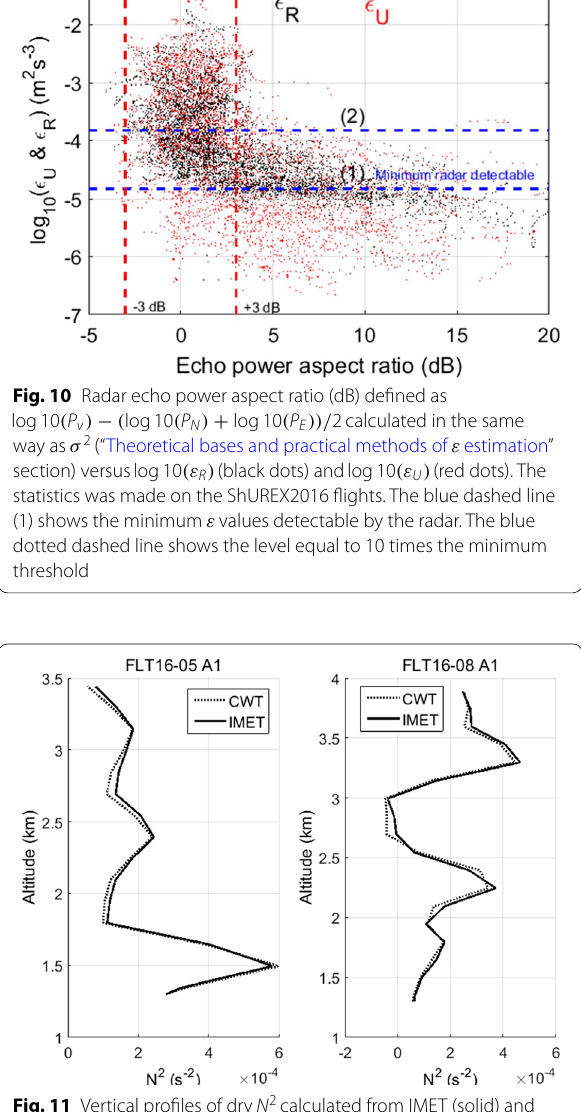
On the other hand, ε W can be estimated from Eq. (3) by performing a numerical integration of I for each altitude z (without L H ). The top panel of Fig. 12 shows the superposition of ε U , ε R , ε N and ε W profiles for FLT16-05 (A1) and FLT16-08 (A1). The ε W profiles appear to be similar to the ε R profiles but are underestimated, typically by a fac- tor ~ 2 with respect to ε R (and ε U ) at almost all altitudes and for both cases. The ε N profiles exhibit more complex